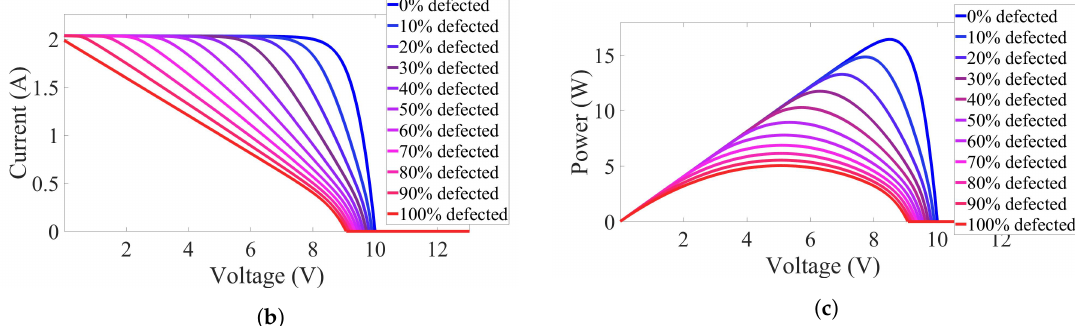
Figure 5. ( a ) Simulation circuit diagram for different levels of hotspots in a PV panel; ( b ) I–V characteristic curves for different levels of hotspots; ( c ) P–V characteristic curves for different levels of